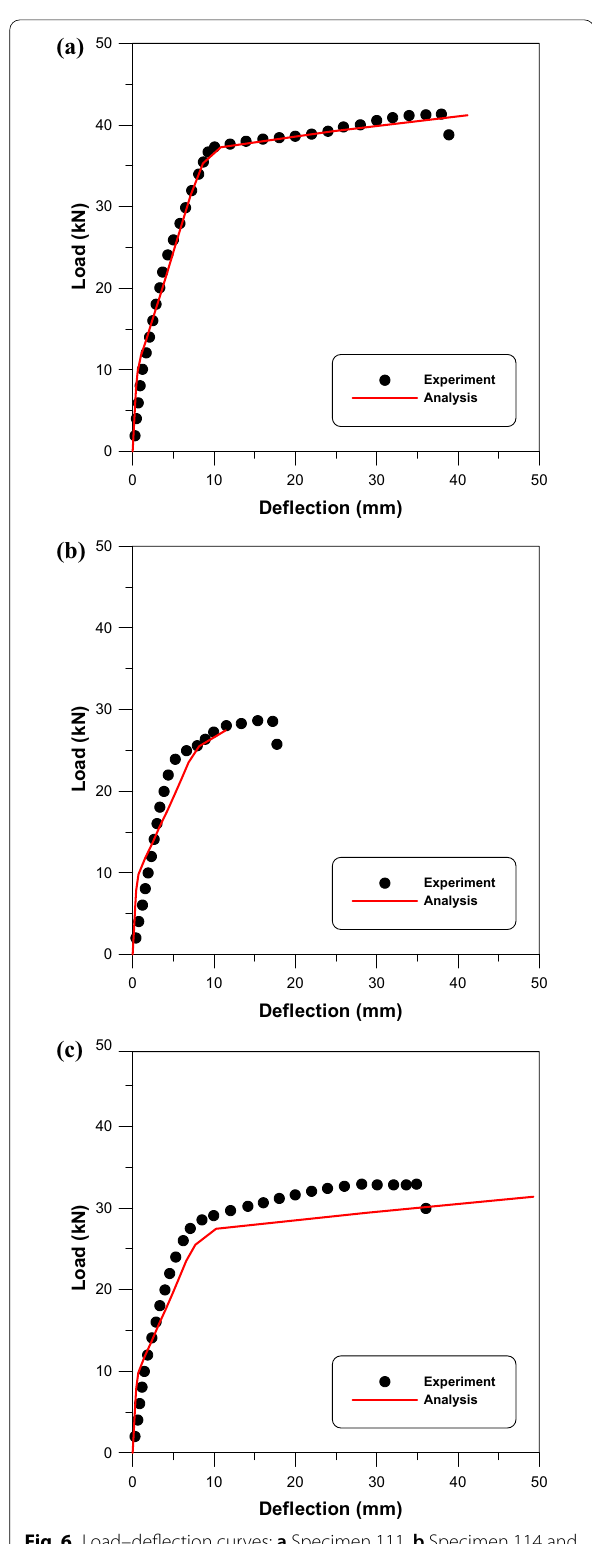
Fig. 6 Load–deflection curves: a Specimen 111, b Specimen 114 and c Specimen